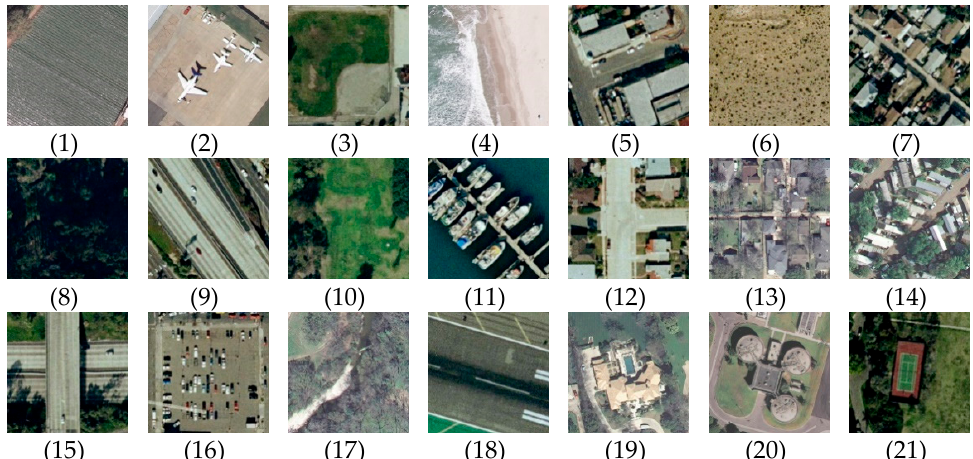
Figure 3. Examples from the UC Merced dataset: (1) agricultural, (2) airplane, (3) baseball diamond, (4) beach, (5) buildings, (6) chaparral, (7) dense residential, (8) forest, (9) freeway, (10) golf course, (11) harbor, (12) intersection, (13) medium-density residential, (14) mobile home park, (15) overpass, (16) parking lot, (17) river, (18) runway, (19) sparse residential, (20) storage tanks, (21) tennis courts. The RSSCN7 dataset contains 2800 remote sensing scene images, which are from seven typical scene categories: grassland, forest, farmland, parking lot, residential region, industrial region, and river and lake. There are 400 images in each scene type, and each image has a size of 400 × 400 pixels. It is important to note that the sample images in each class are sampled on four different scales with 100 images per scale with different imaging angles. The RSSCN7 dataset is a challenging and representative scene classification dataset due to the wide diversity of the images, which are captured under changing seasons, varying weathers, and sampled on different scales [64], as shown in Figure 4.